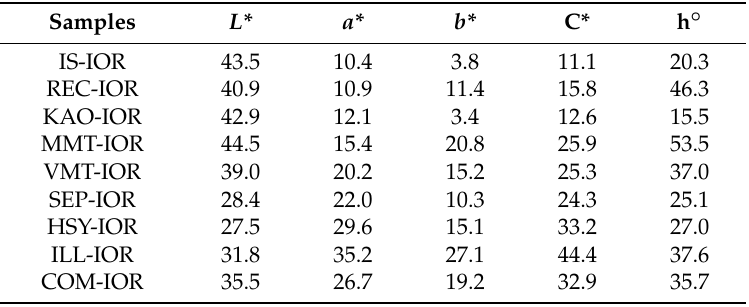
Table 2. CIE- L* , a *, b *, C* and h ◦ values of the iron-red hybrid pigments.